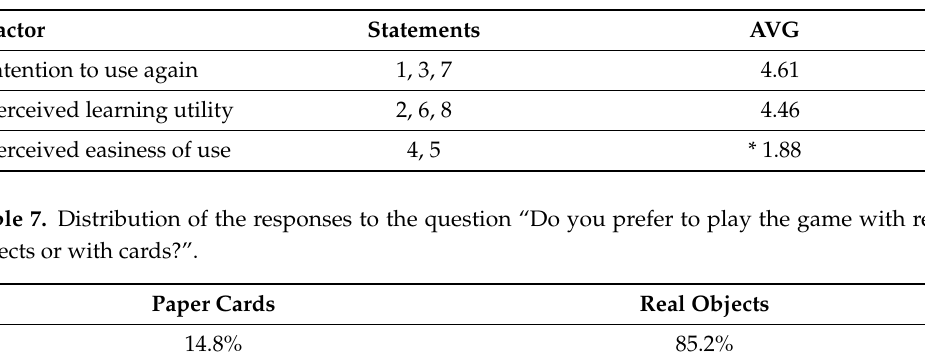
Table 6. Results of the Satisfaction and Usability Questionnaire presented in Table 5 averaged (AVG) by factors. Note that, in opposition to all other factors, the lower the value obtained for perceived easiness of use , the better. This inverted value is annotated with *.